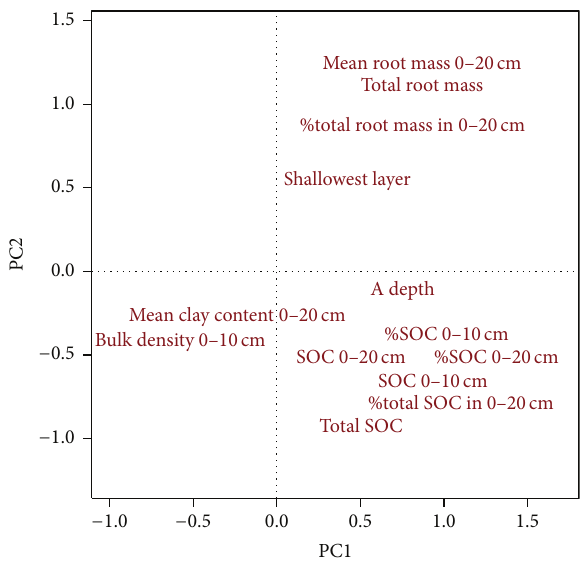
Figure 2: Relationships among 13 belowground properties with respect to first two Principal Components from Principal Compo- nents Analysis. For description of plotted text codes and quantified loadings for each variable, see Table 4. Figure 3: Results of a constrained ordination of plant community